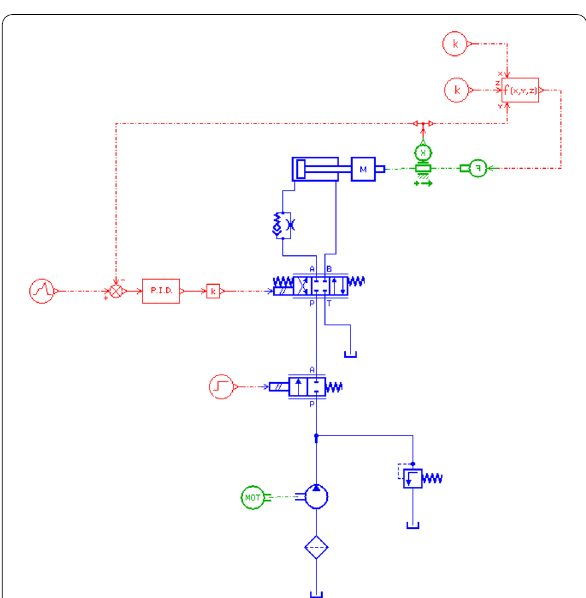
Figure 6 AMESim model of the height control